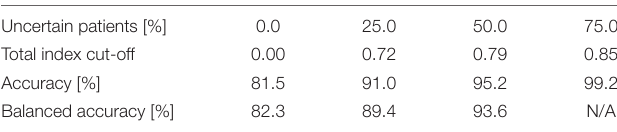
The columns show for different percentages of left out patients the DSI threshold used for rejecting uncertain patients, and the accuracy and balanced accuracy obtained when the patients are left out of the classification.